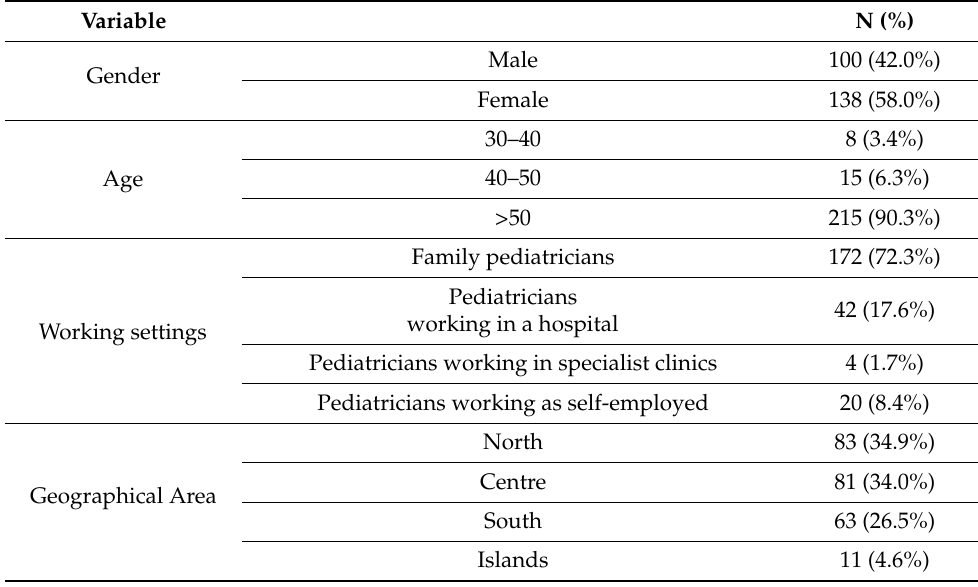
Table 1. Respondent